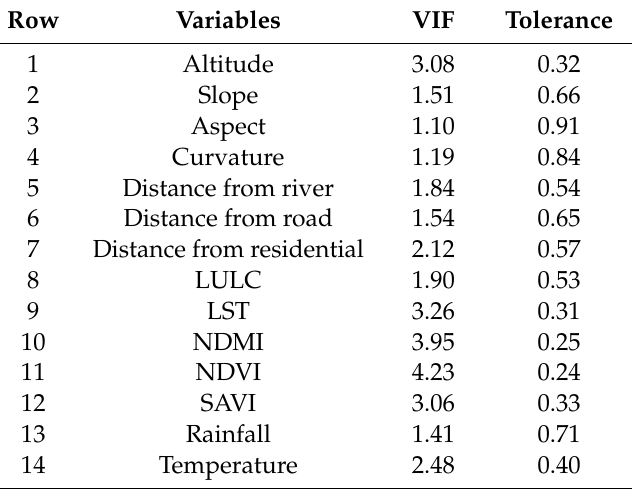
Table 2. Multi-collinearity assessment